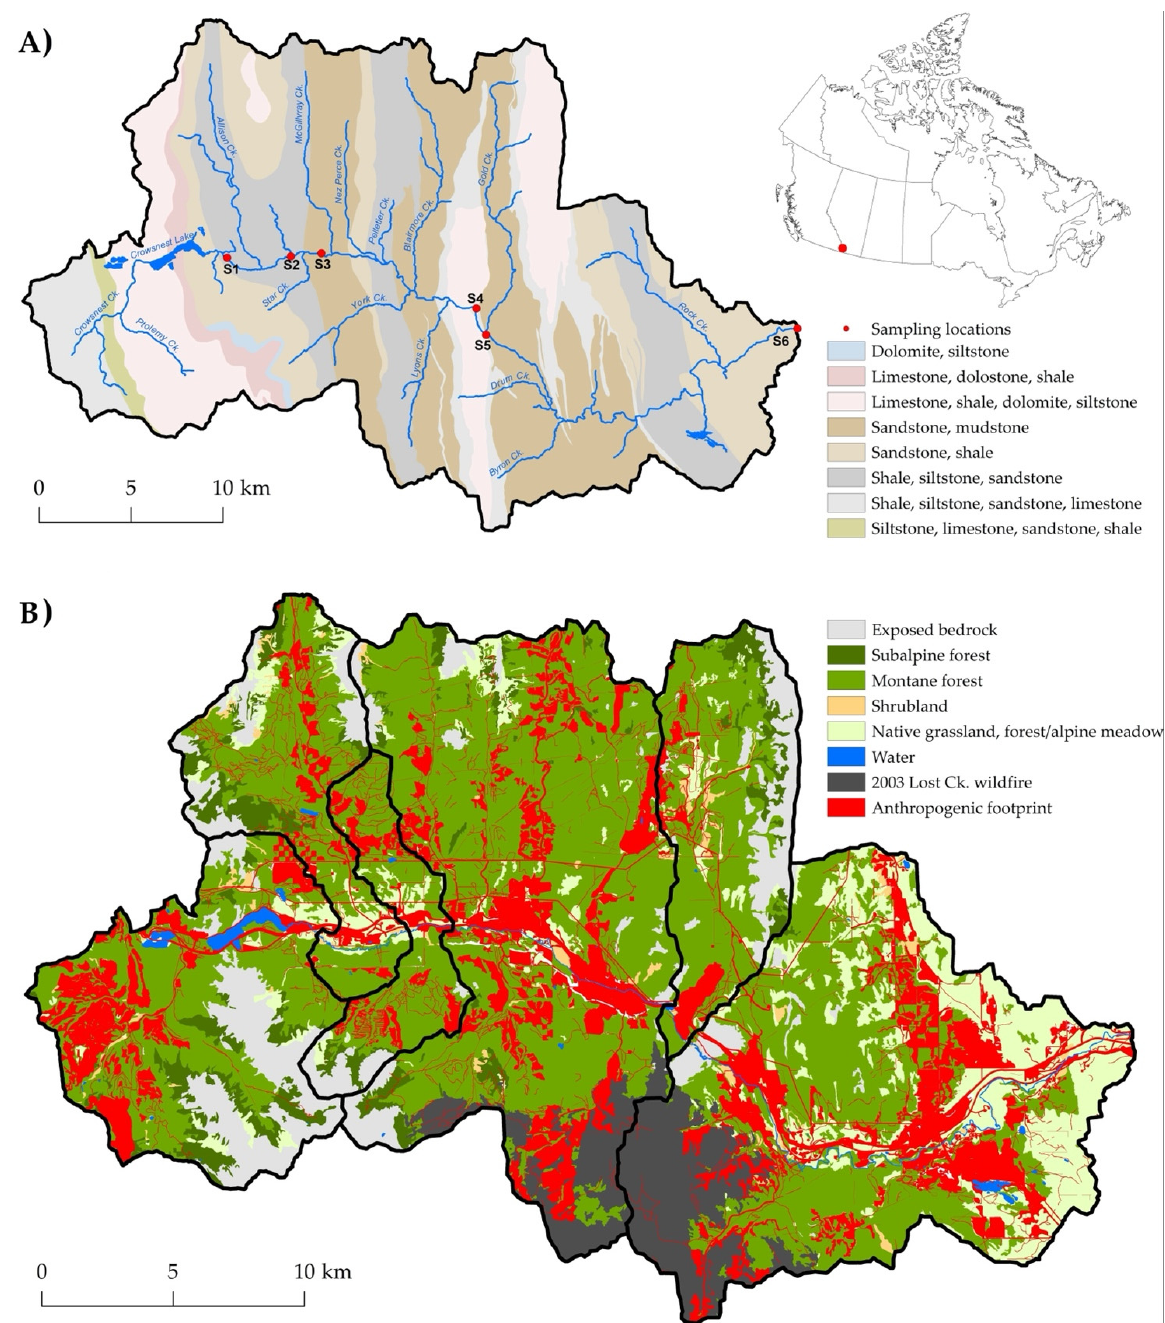
Figure 1. ( A ) Hydrography, study sampling locations, and bedrock lithology [46], and ( B ) sampling location sub-watersheds, land cover, and historic natural-anthropogenic disturbance footprint (to 2016) [42–45] in the Crowsnest River basin. Digital provincial boundaries were available from Statistics Canada [47].